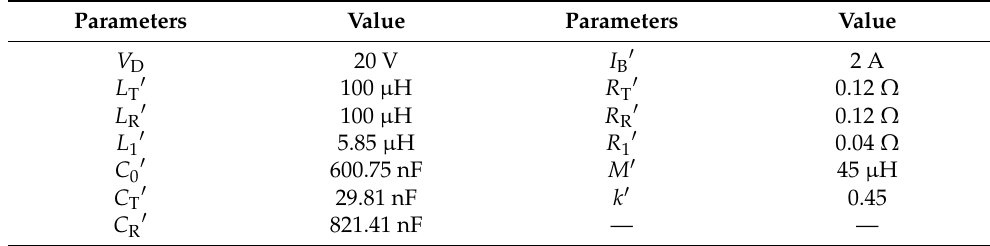
Table 3. Theoretical circuit parameters of the CLC/S compensated WPT system.